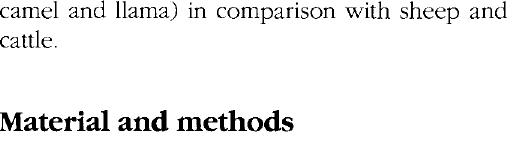
Fig. 1. The effect of fasting on Fig. 2. The effect of fasting on blood non-esterified fat-